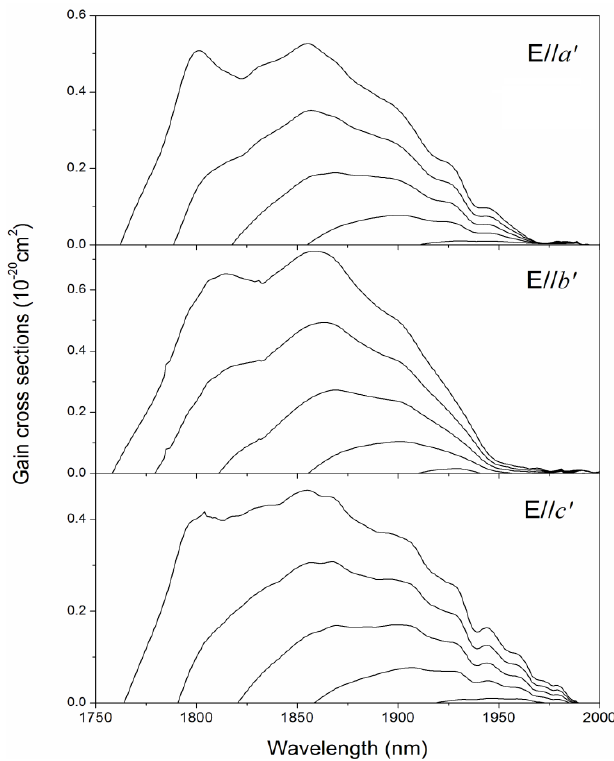
Figure 7. Fluorescence decay curves of 3 H